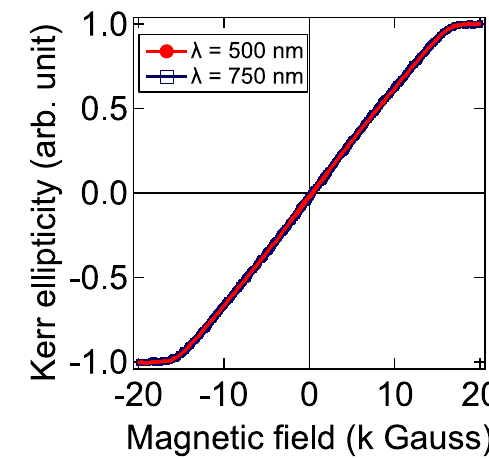
Figure 4. ( a ) Transmission spectrum of 20 nm-thick Co thin film. ( b ) Magnetic field dependence of normalized complex Kerr rotation in longitudinal configuration (L-MOKE curve) for 20 nm-thick Co thin film. ( c ) Magnetic field dependence of normalized Kerr ellipticity in polar configuration (P-MOKE curve) for the Co thin film with two different incident wavelengths ( λ ): 500 nm (red circles and line) and 750 nm (blue hollow squares and